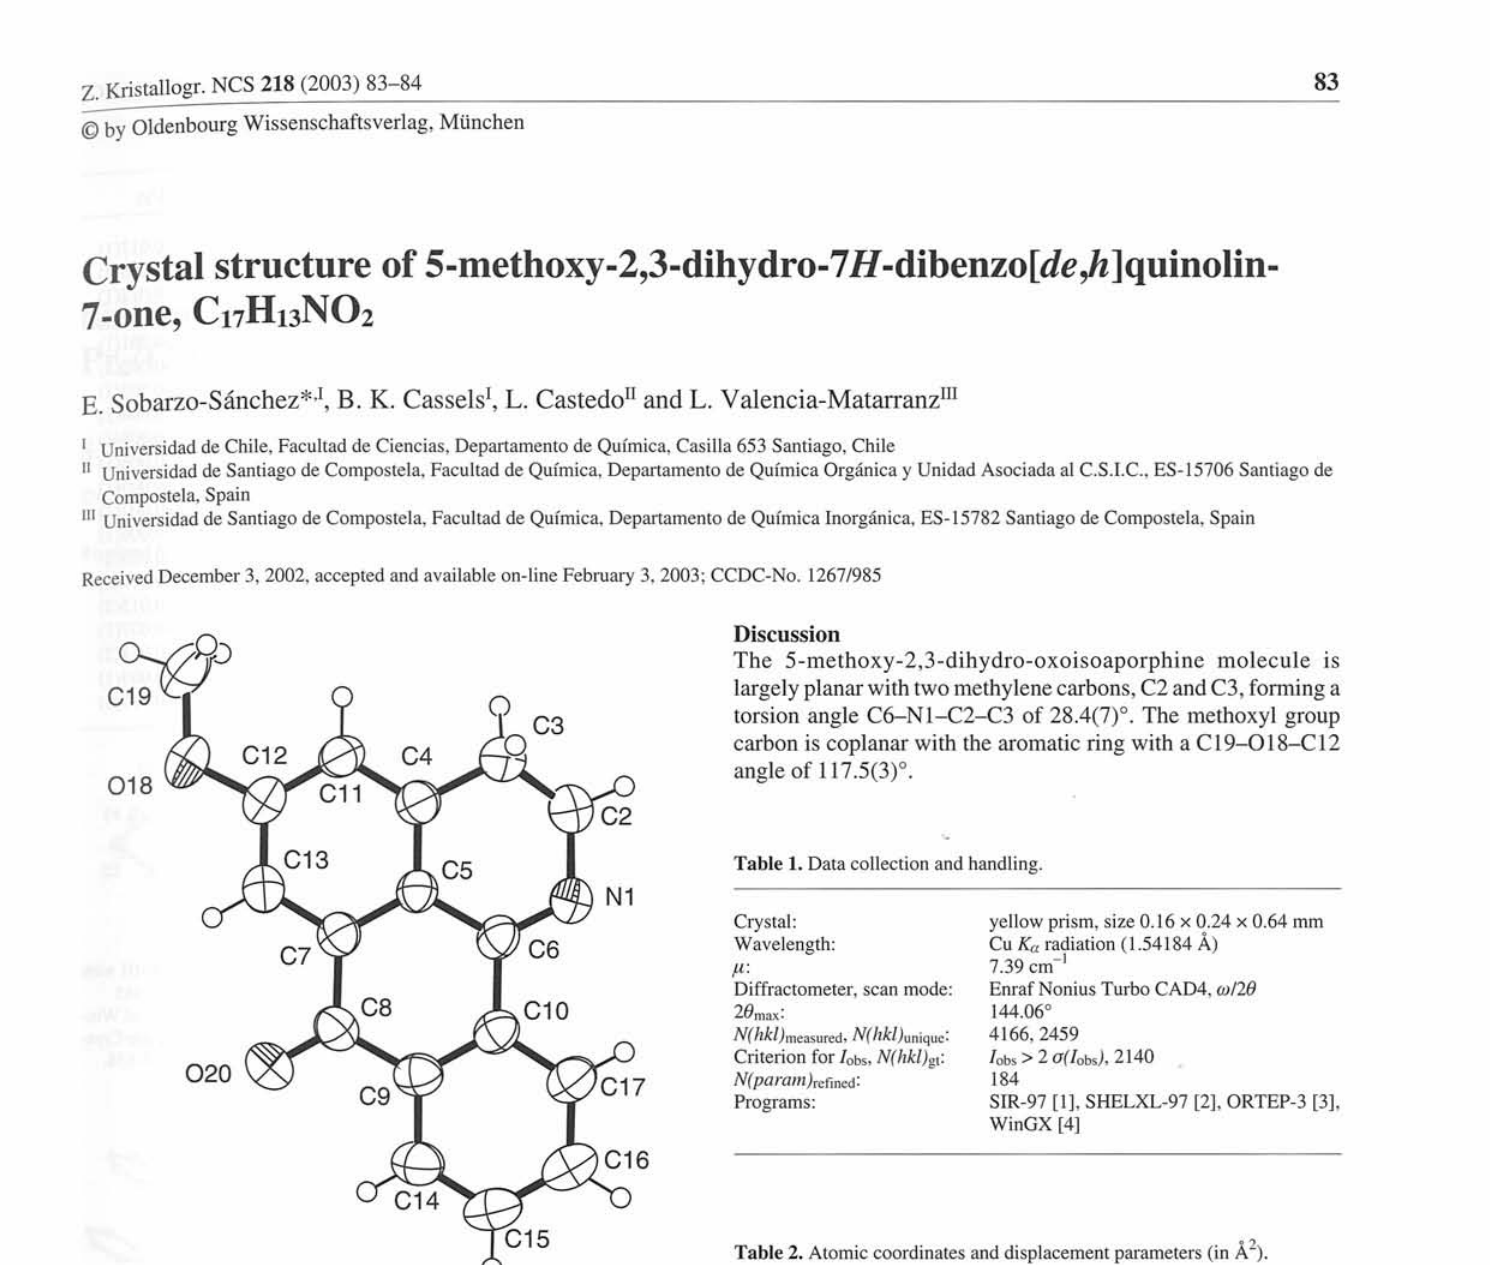
Table 2. Atomic coordinates and displacement parameters (in A